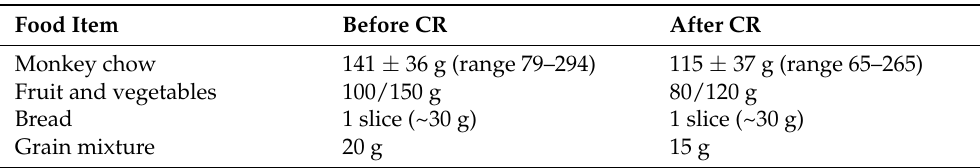
Table 1. The amount of food per individual in the diet of the long-tailed macaques at the Biomedical Primate Research Centre (BPRC) before and after mild caloric restriction (CR) was initiated in August 2017. The variation reflects variation in the amount of food for individuals of different ages and body